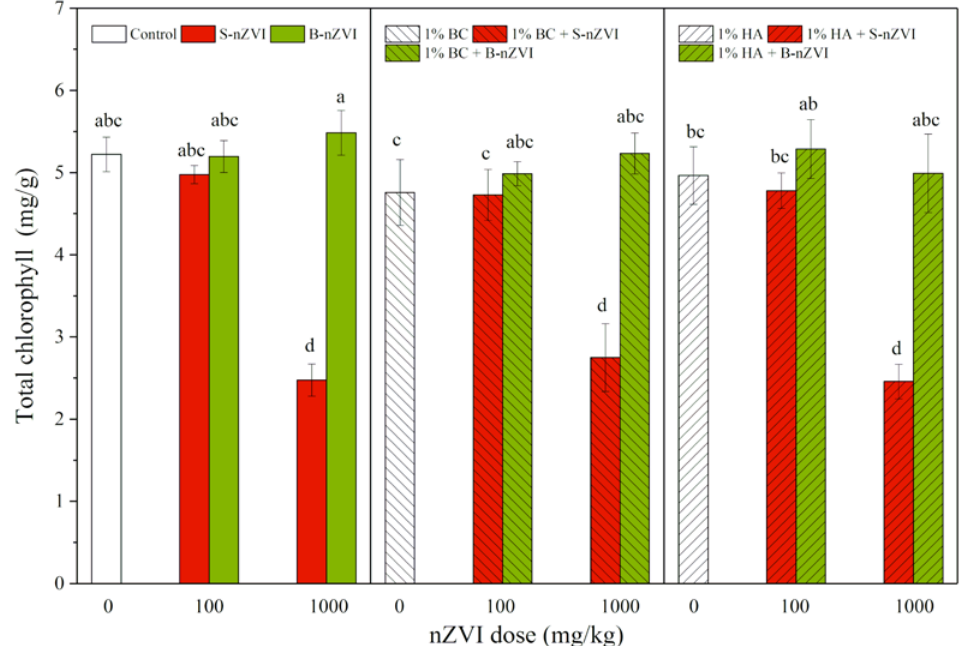
Figure 5. Total chlorophyll (means ± SD, n = 4) in leaves of mung bean seedlings exposed to nZVI alone or in combination with BC or HA. Different letters on the bars indicate significant differences among all means in different treatments using a one-way ANOVA followed by a Duncan’s multiple range test ( p < 0.05). Three-way ANOVA results are shown in Table 2.